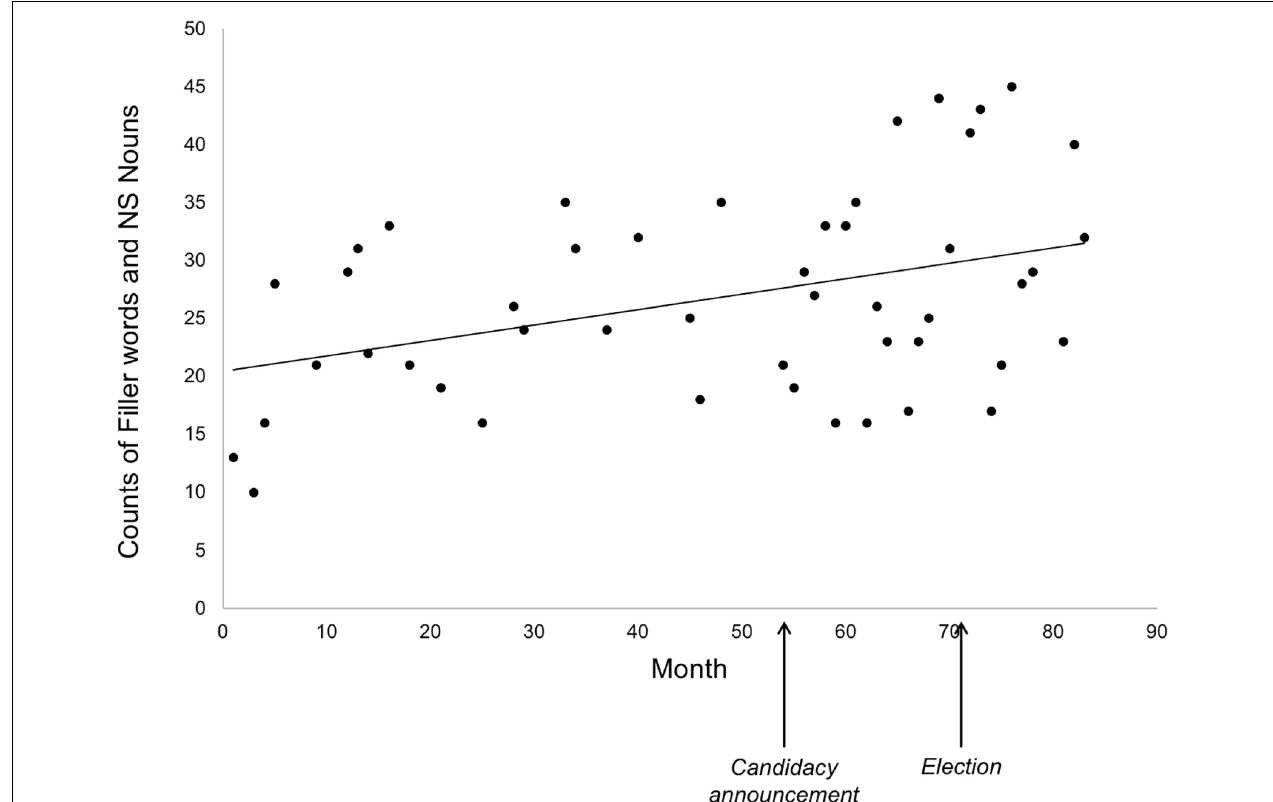
FIGURE 1 | Number of fillers and NS nouns in unscripted interview discourse by Donald J. Trump over time. All transcripts are from the first 1,000 words of unscripted interviews between January 2011 (month 1) and November 2017 (month 83). Months of official candidacy announcement and election are